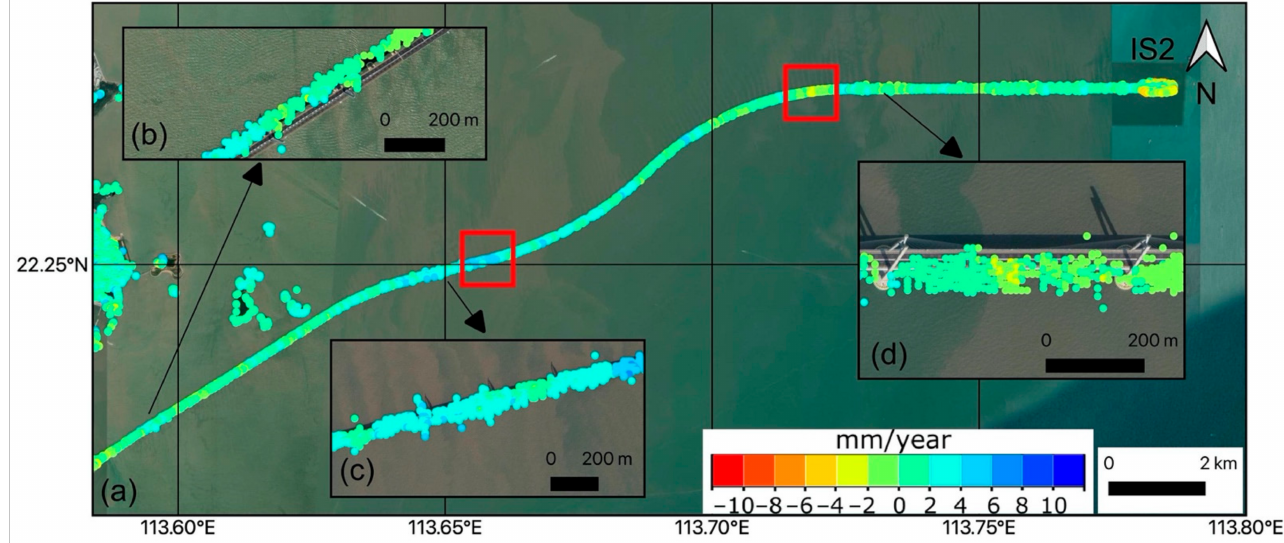
Figure 8. The close-up shows displacements of ( a ) the main HZMB and three bridges: ( b ) JZB, ( c ) JHB and ( d ) QZB. The background is the satellite image from Google